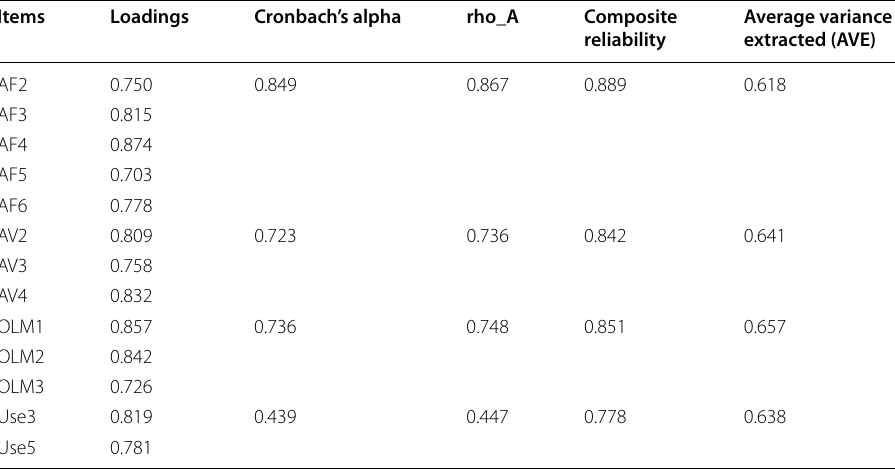
Table 2 Internal consistency measure for variables of the study. Source : Field survey (2021) Items